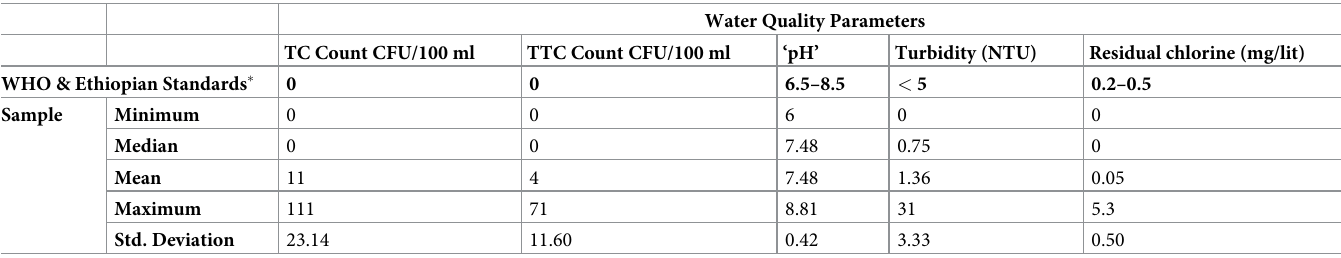
Table 6. Summary of water quality results of basic water services sample (n = 111) in comparison to WHO and Ethiopian